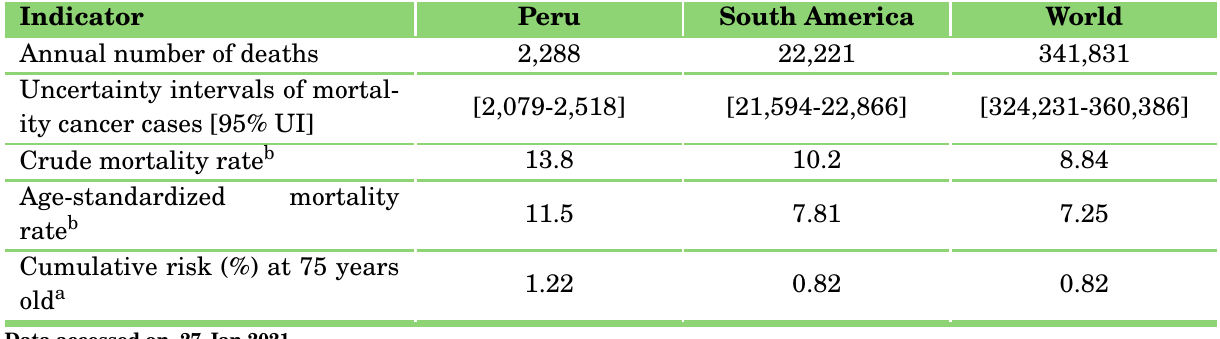
Table 5: Cervical cancer mortality in Peru (estimates for